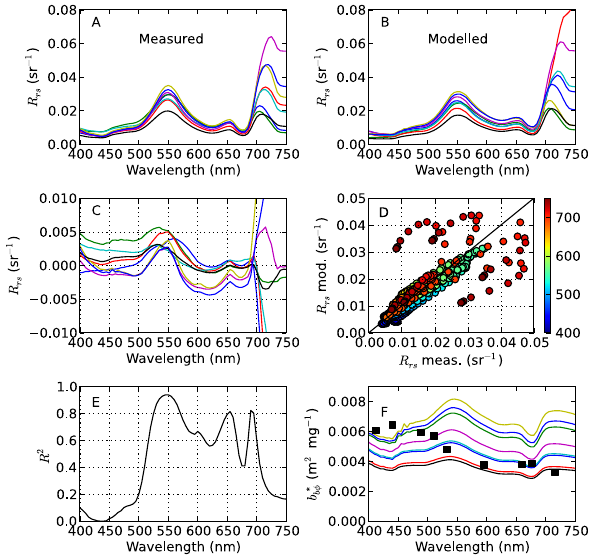
Fig. 7. Tuning of the two-layered sphere model using measured R rs . (A) Measured and (B) modelled R rs and (C) the difference be- tween the measured and modelled R rs . (D) Scatterplot of measured and modelled reflectance coloured by wavelength. (E) Wavelength- specific R 2 between measured and modelled R rs ( N =8). (F) b ∗ corresponding to various shell layer 1+ (cid:15) values determined by fit- ting the measured and modelled R rs , and that measured by Zhou et al. (2012) (squares). Colours in (A) , (B) , (C) and (F) represent different